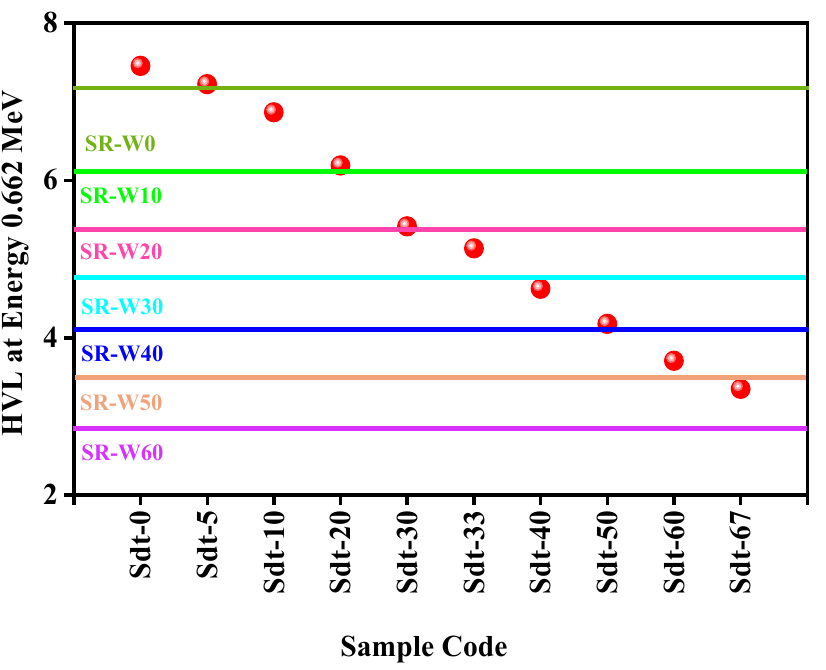
Figure 14. The comparison of HVL between the WO 3 -containing silicone rubber (SR-W0) system with iron ore-containing silicone rubber (Sdt-0) systems at energy 0.662 MeV.